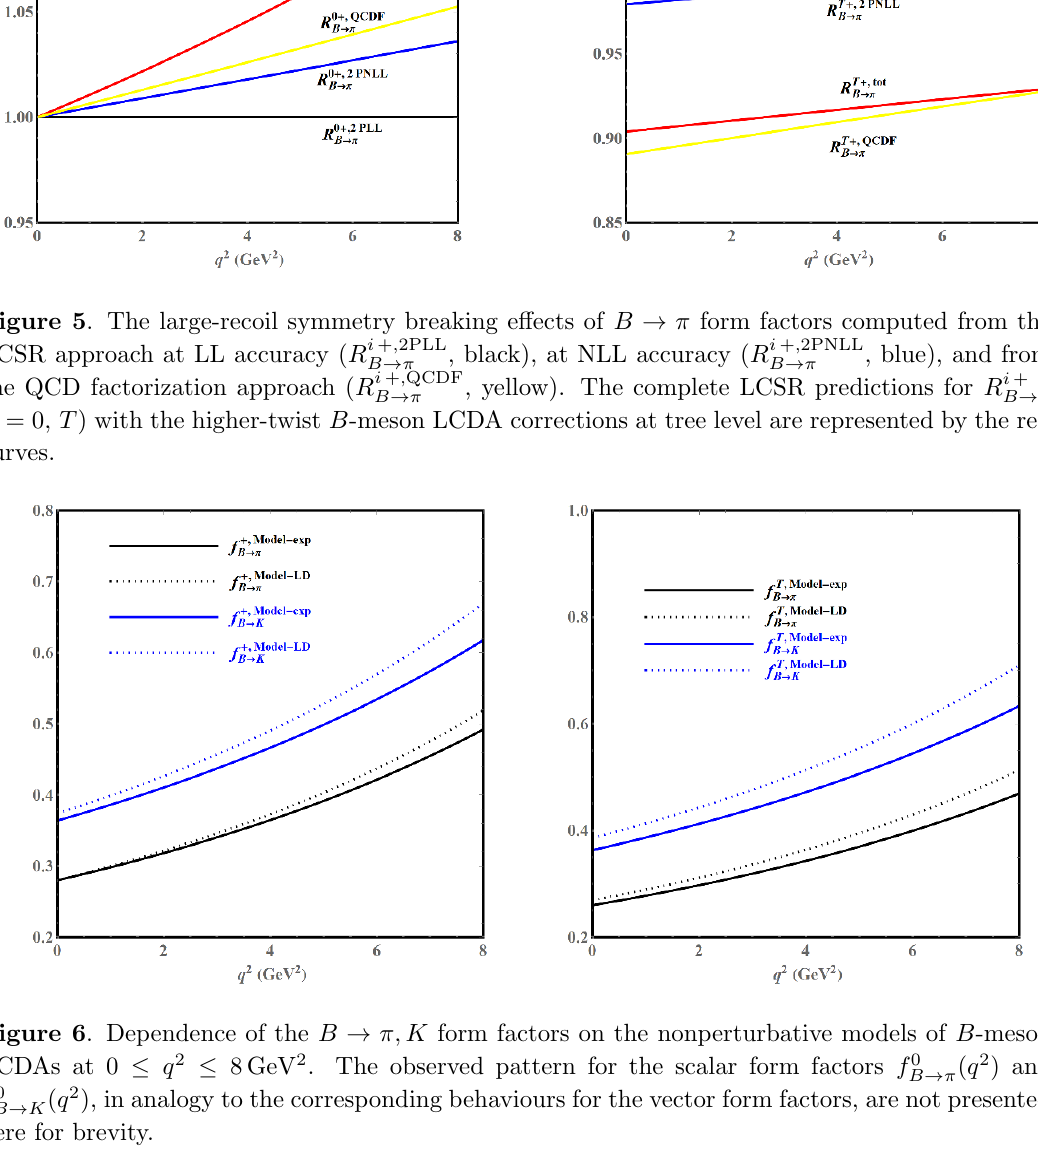
( q 2 ) and B ! (cid:25)